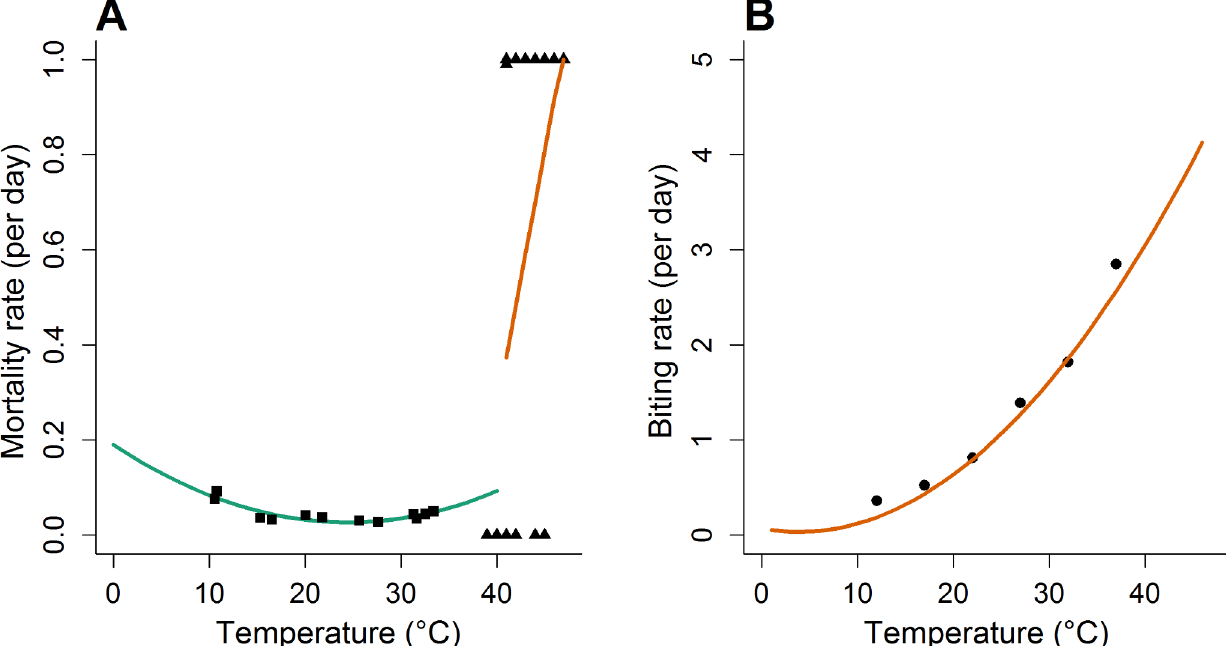
Fig 1. Daily temperature dependent morality and biting rate over a range of temperatures. A) Daily temperature dependent mortality, triangles indicate data from Christophers (1960)[36] and squares data from Yang et al., (2009)[35]. The lines depict the linear relationship between temperature and mortality below 41˚C (green) and above 41˚C (red). B) Daily biting rate against temperature from Martens (1998)[44]. Black dots show the data and the red line the polynomial fit.